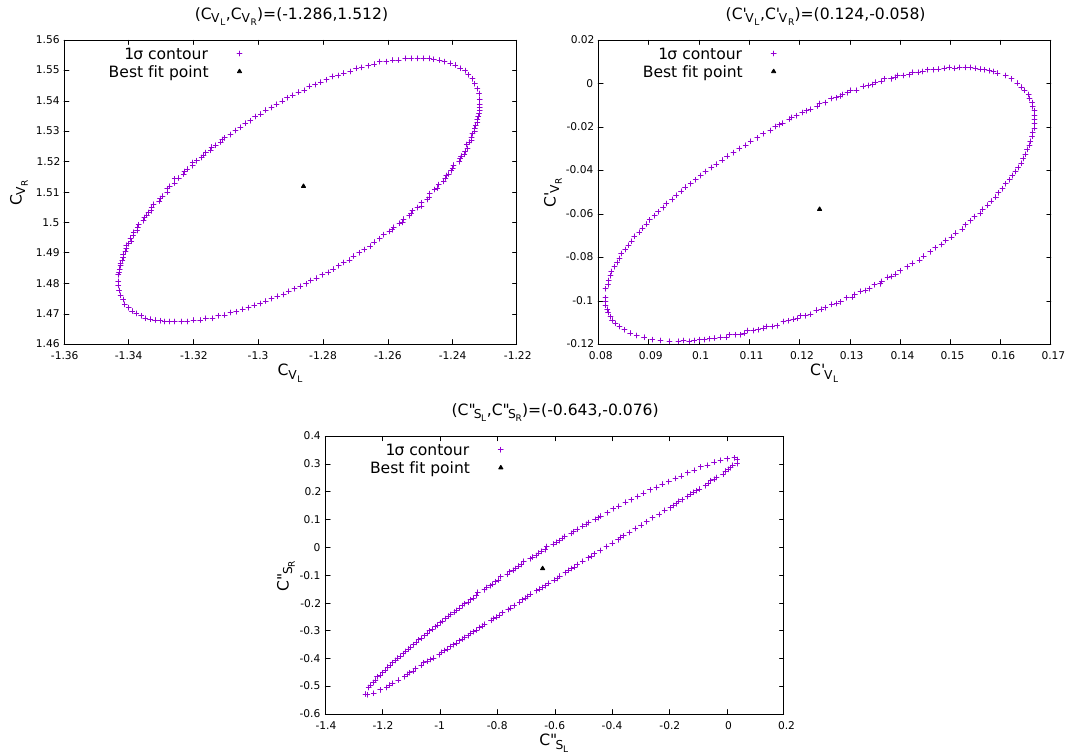
Figure 1. The allowed 1 (cid:27) ellipses for the two parameter solutions listed in table 4.